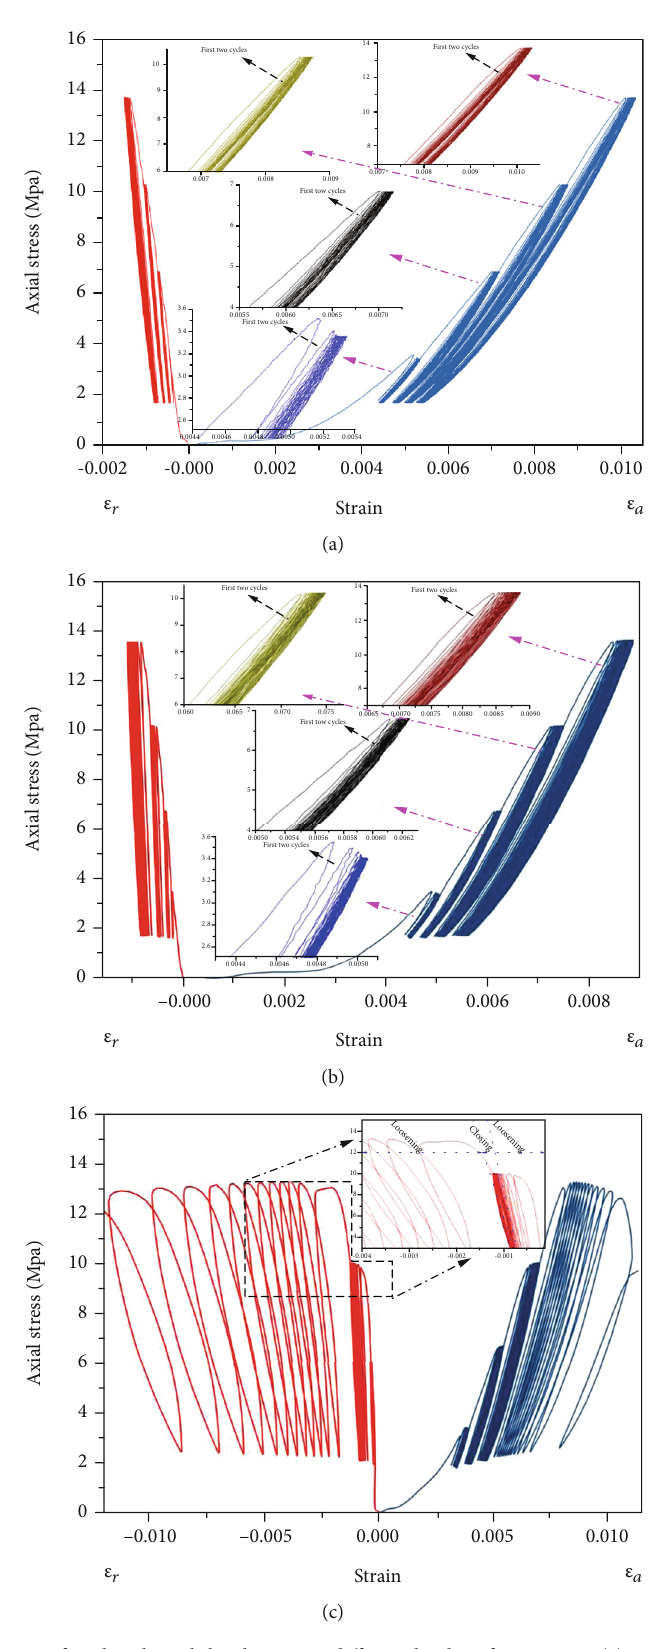
Figure 4: Stress-strain curves of coal with multilevel stress at di ff erent loading frequencies: (a) 0.1Hz; (b) 0.2Hz; (c)